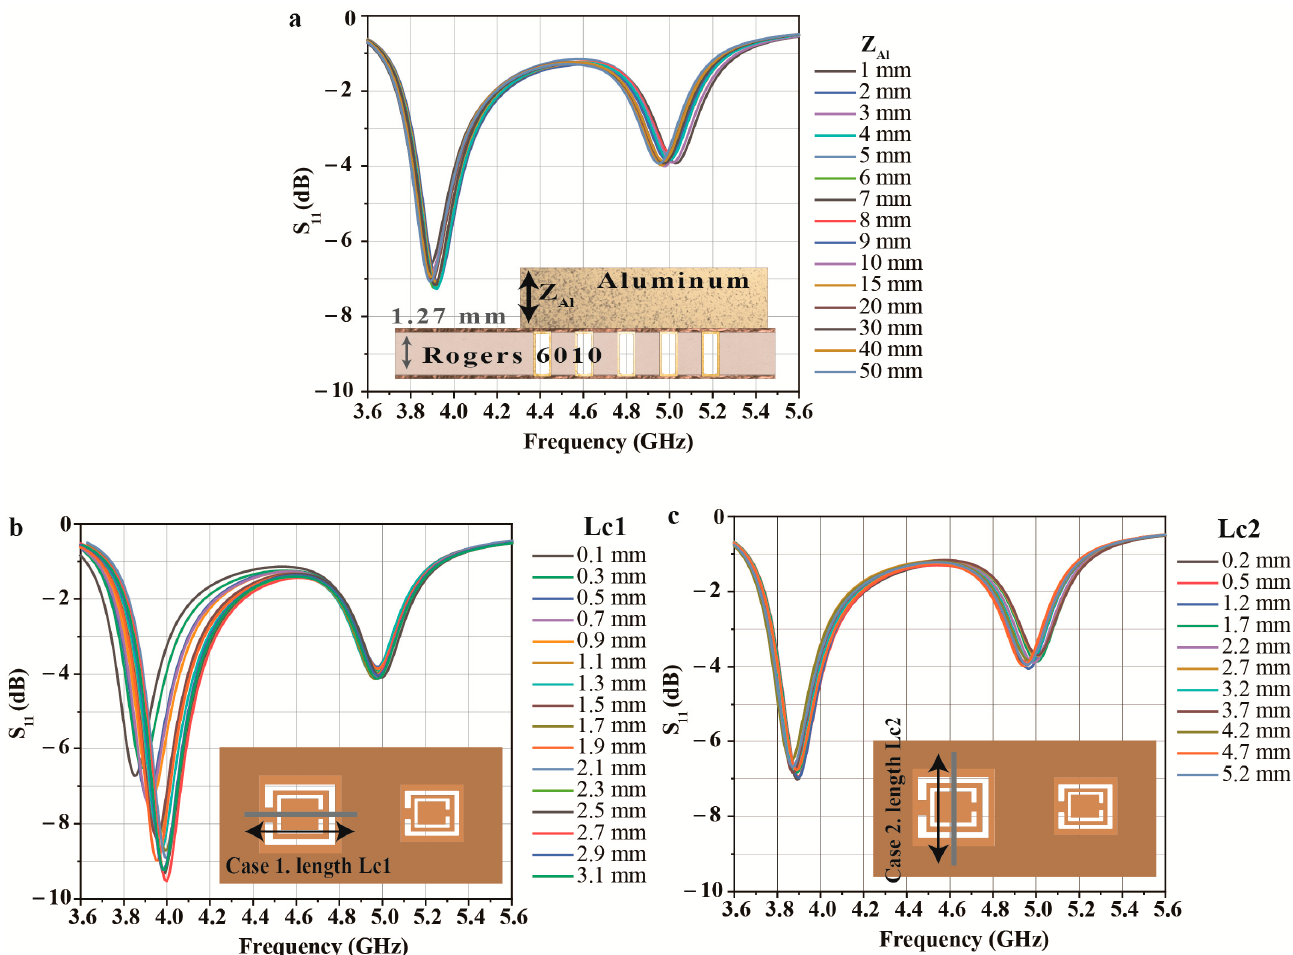
Figure 7. Simulation results of the proposed sensor for ( a ) different Al sheet thicknesses and ( b , c ) crack lengths.